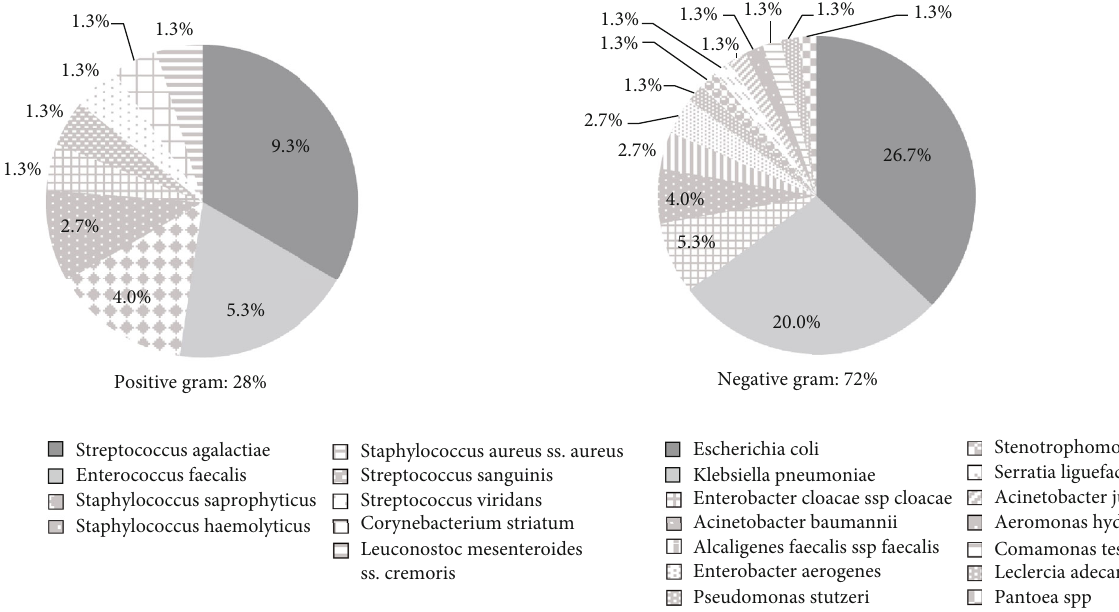
Figure 1: The pattern of bacteria found in pregnant women with asymptomatic bacteriuria in Jakarta,